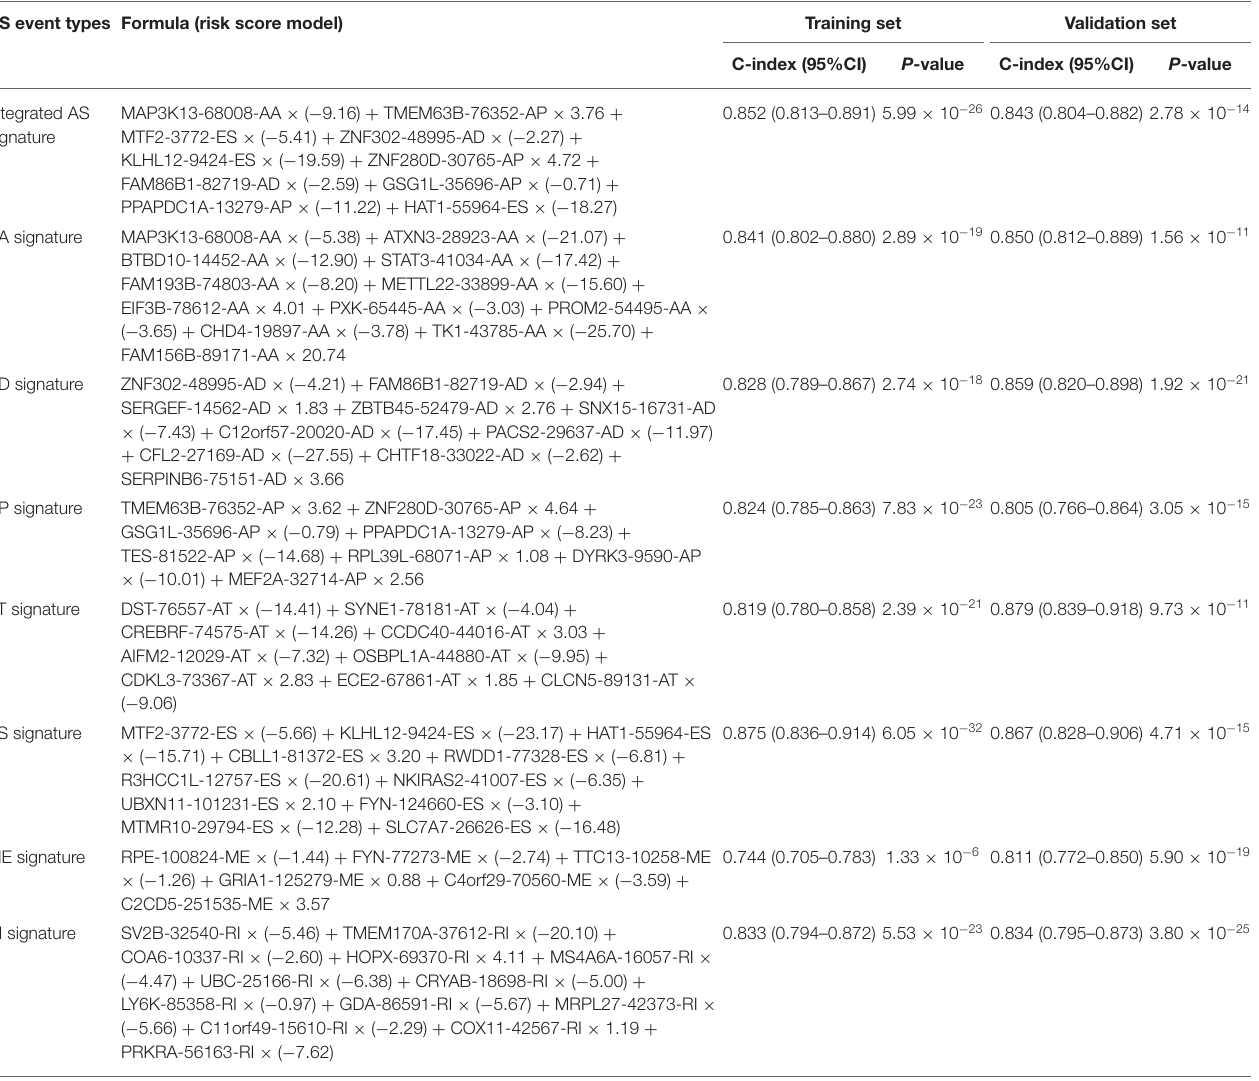
TABLE 2 | The prognostic risk score models based on the PSI values of AS event types of GBM training cohort and C-index of the training and validation cohort. AS event types Formula (risk score